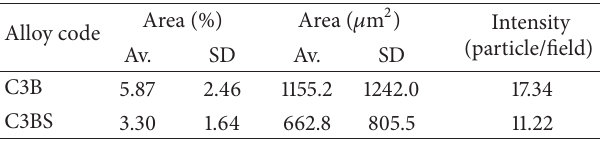
Table 5: New reaction particle measurements for the as-cast 357